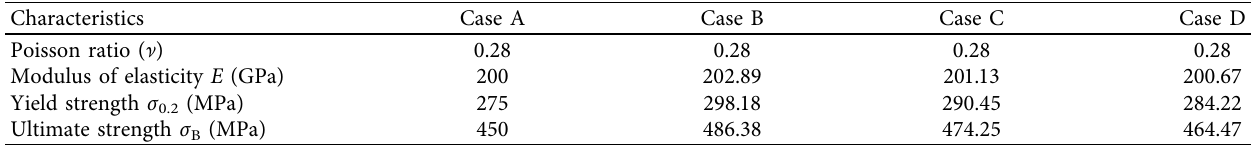
Table 10: Mechanical properties of bent